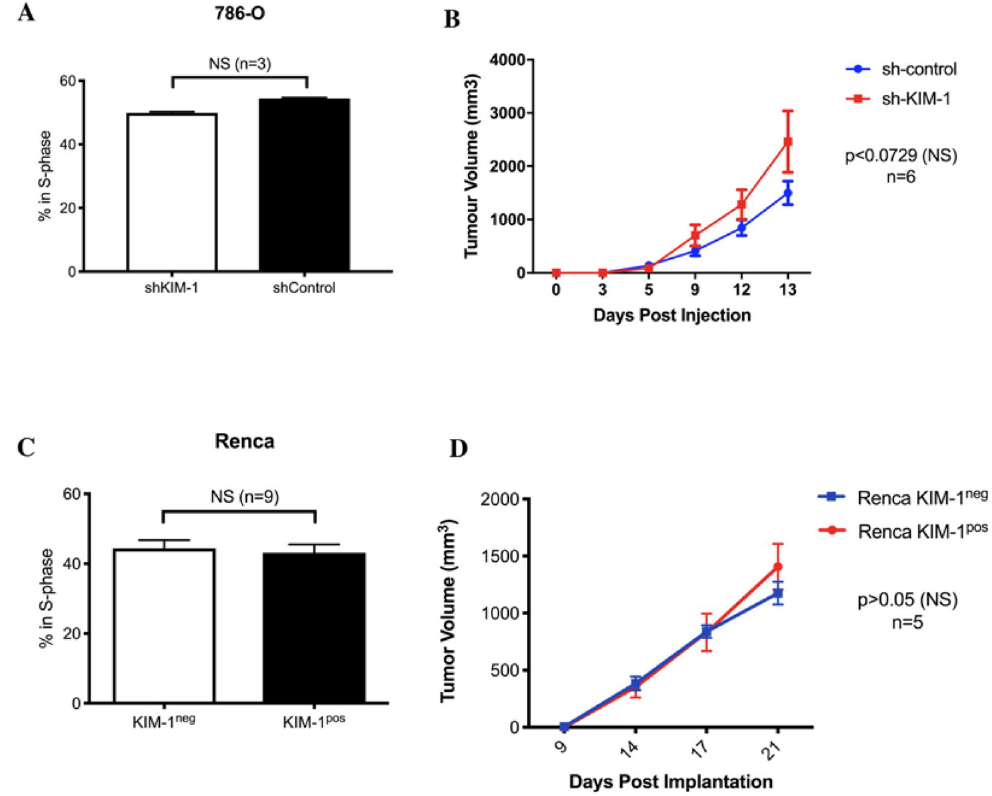
Figure 2. KIM-1 expression does not alter the proliferation or spontaneous generation of tumours by human and murine RCC cells. ( A ) Quantification of proliferation responses of human RCC 786-O-shControl and 786-O-shKIM-1 cell lines using BrdU (Bromodeoxyuridine) assay. Data are represented as mean ± SD of n = 3 independent experiments (p = 0.1000, NS). ( B ) 786-O-shControl and 786-O-shKIM-1 tumour volumes (mm 3 ) and pictorial representation after 15 days of incubation in immune deficient Rag1 −/− Balb/c mice. Data are represented as mean ± SD of n = 6 independent experiments (p < 0.0729, NS). ( C ) Quantification of proliferation responses of Renca KIM-1 pos and Renca KIM-1 neg cell lines using BrdU (Bromodeoxyuridine) assay. Data are represented as mean ± SD of n = 9 independent experiments (p = 0.4363, NS). ( D ) Renca KIM-1 pos and Renca KIM-1 neg tumour volumes (mm 3 ) and pictorial representation after 21 days of incubation in immune deficient Rag1 −/− Balb/c mice. Data points are represented as mean ± SD of n = 5 independent experiments (p > 0.05,